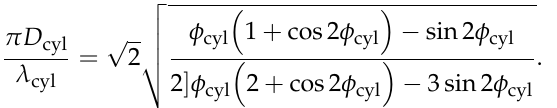
Figure 8. Schematic of a segmented cylindrical melt pool in the study of Gsarov and Smrov [3]. Based on Figure 8, the necessary and sufficient condition for Plateau–Rayleigh insta- bility to arise was derived in [3]. The condition is as follows: